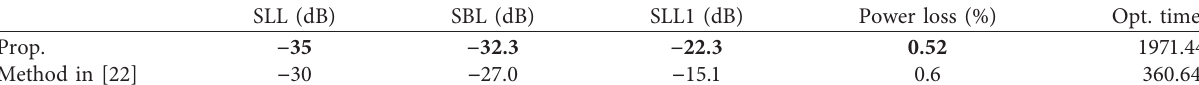
Table 2: Comparison of the optimized results between the proposed method and the method in [25].